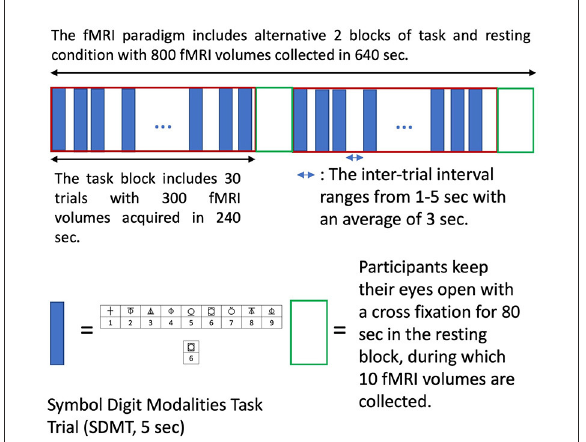
FIGURE2 The semi-random design of task fMRI paradigm. The semi-random task paradigm (maximizing both estimation efficiency and detection power) includes two alternative tasks and resting conditions blocks (640 sec). Each task block has 30 symbol digit modalities task (SDMT) trials. Each trial takes 5s with a random inter-trial interval ranging from 1–5s (average of 3s). The SMDT requires participants to determine if the lower symbol digit pair agrees with upper symbol-digit references and respond with yes and no keys. Participants keep their eyes open with a cross fixation during the inter-trial intervals and the resting